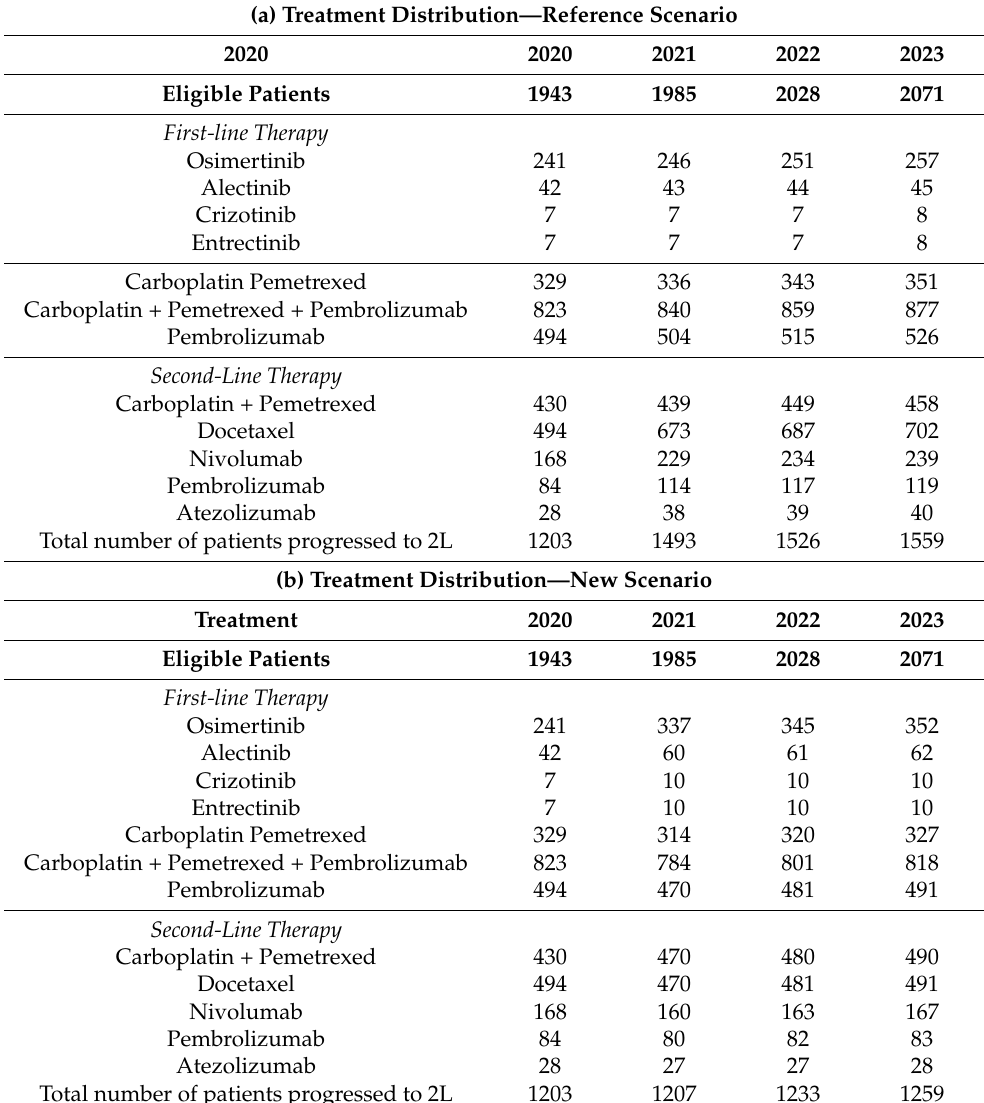
Table 3. ( a ) Treatment distribution—reference scenario. ( b ) Treatment distribution—new scenario. (a) Treatment Distribution—Reference